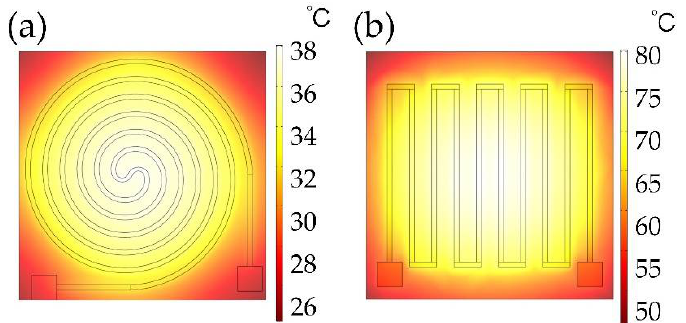
Figure 3. The temperature distribution of ( a ) Circular-shaped structure, and ( b ) S-shaped structure in steady-state.